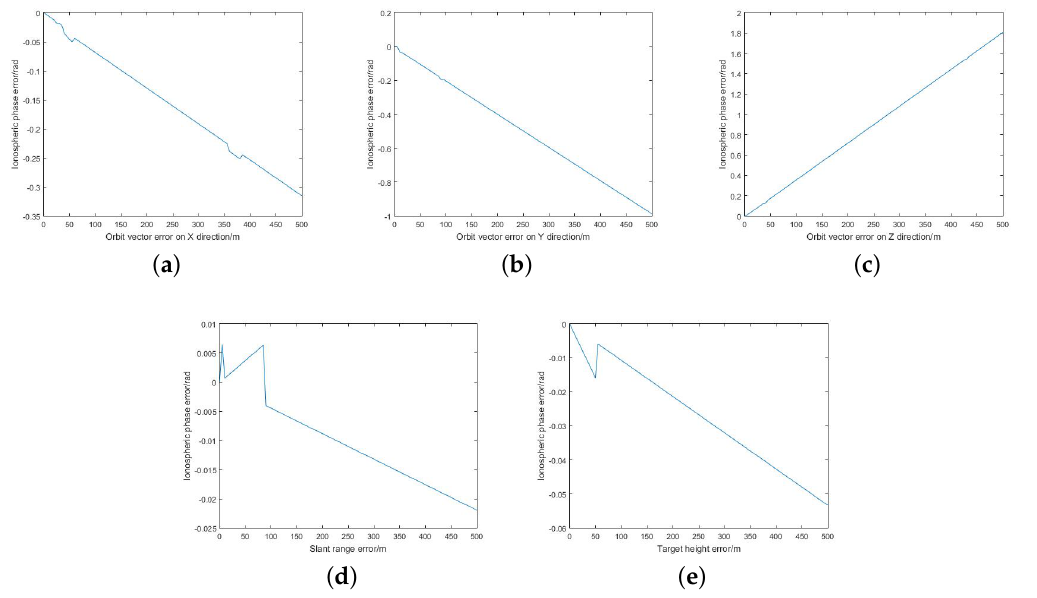
Figure 7. The relationship between error in different factors and ionospheric phase error on 20080131 and 20080317: ( a ) shows ionospheric phase error when error added in X direction of orbit vector. ( b – e ) are ionospheric phase error changing with Y s , Z s , R and h